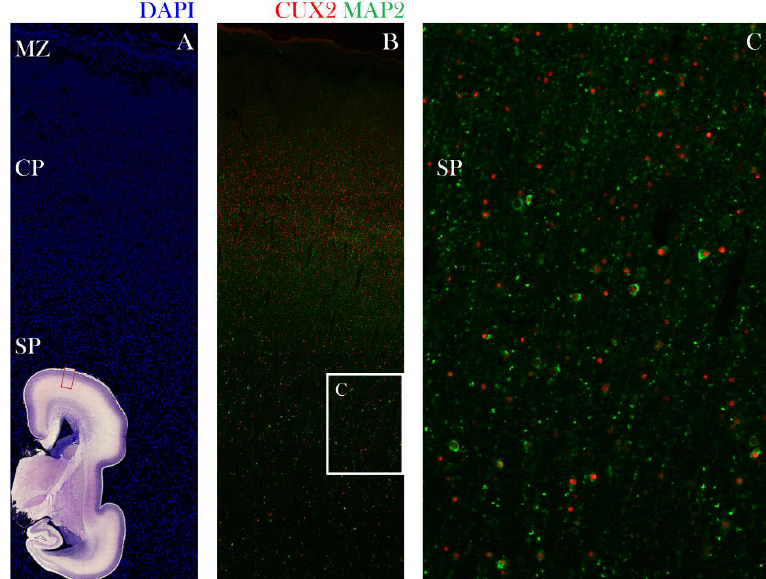
Figure 5. CUX2+ nuclei co-localize with MAP2 immunopositive neurons in the SP during the midgestation stationary phase at 21 PCW. Representative confocal images of the lateral dorsal part of the cerebral cortex in the prospective precentral area (indicated by red box on the inset representing complete scan of coronal Nissl section shown in lower left corner) is shown on the following sections ( A,B,C ). Developing neocortex was immunostained for CUX2 (red), neuronal marker MAP2 (green) and DAPI (blue). ( A,B ) The cell dense CP (A) contains CUX2+ nuclei in the mid third of the CP ( B ). MAP2 co-localizes with CUX2+ nuclei during the midgestation phase in the MZ, CP, and SP. ( C ) Higher magnification of box in B shows that a portion of MAP2+ neurons are also CUX2+ cells in the SP ( C ). Scale bar = 100 µm.